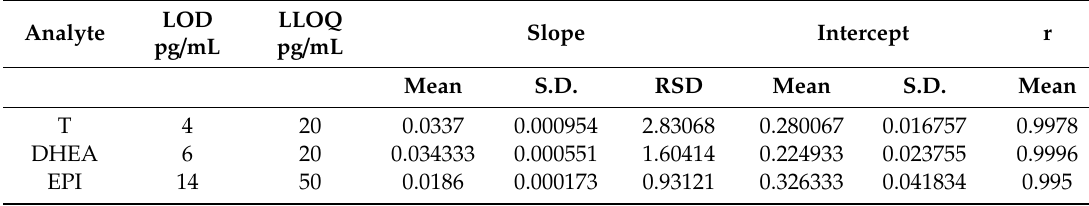
Table 5. Calibration Curve Parameters ( n = 3).